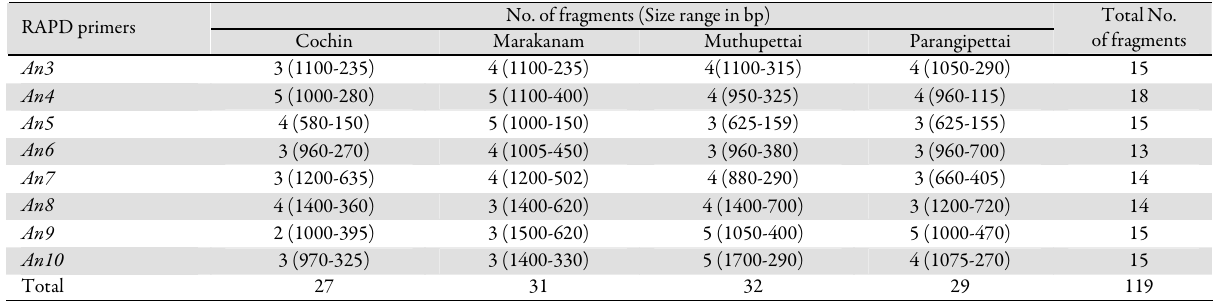
Tab.1. Number and size of the fragments produced by eight RAPD primers and molecular weight of the bands in four populations of E. machnata